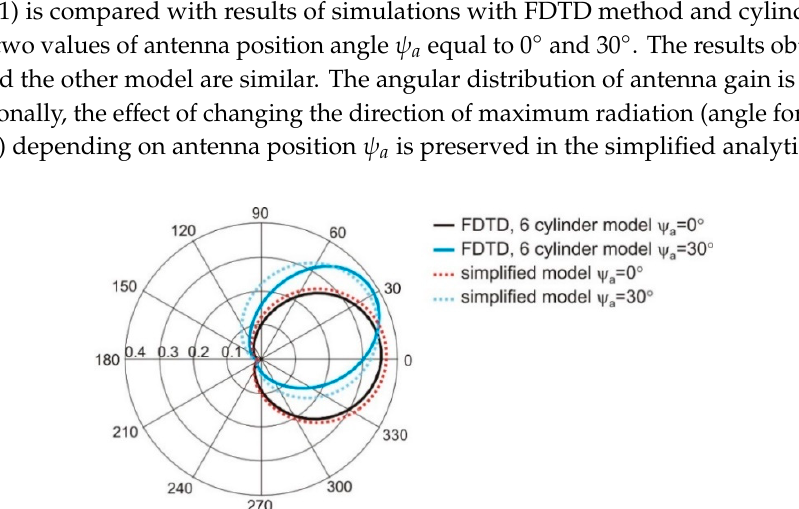
Figure 5. The radiation pattern of the wearable antenna array obtained with FDTD based simulations and the cylindrical model of the body compared to results obtained with the simplified model given by Equation (2) for various values of G 0 .